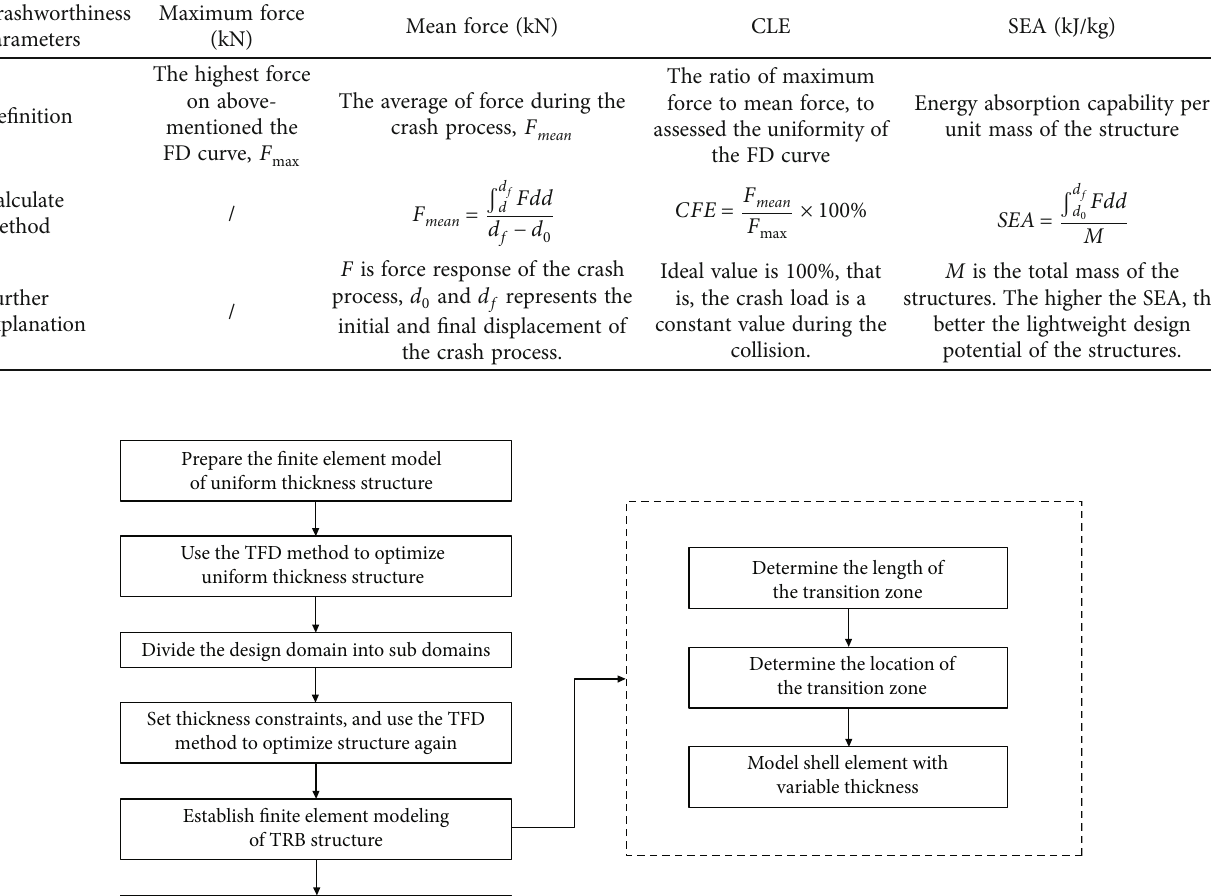
Table 1: Crashworthiness